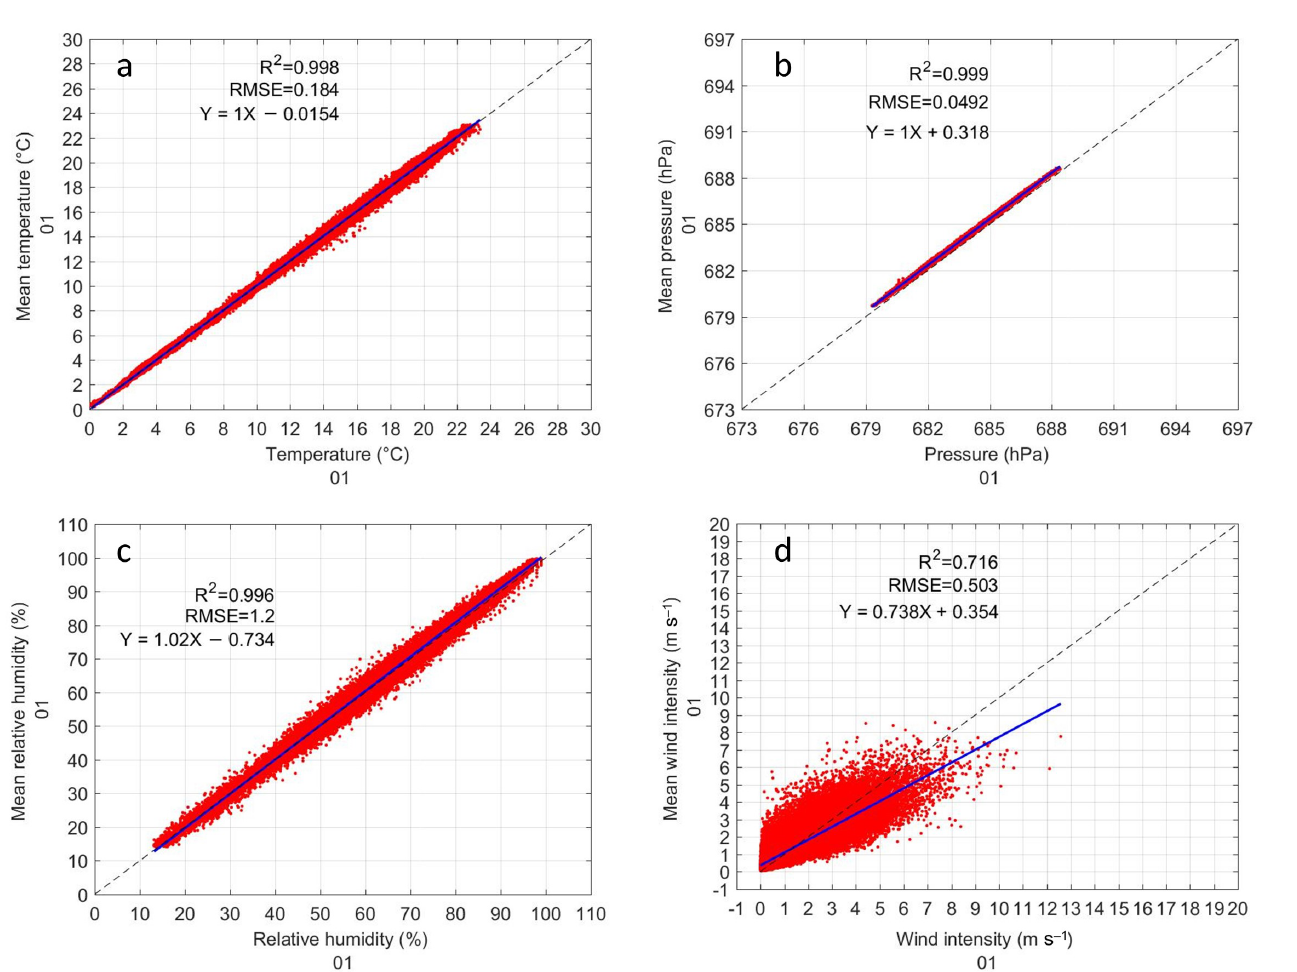
Figure 11. Inter-comparison of GMX500 sensor 01 after correcting the settings in the data logger: ( a ) Inter-comparison of temperature. ( b ) Inter-comparison of pressure. ( c ) Inter-comparison of relative humidity. ( d ) Inter-comparison of wind